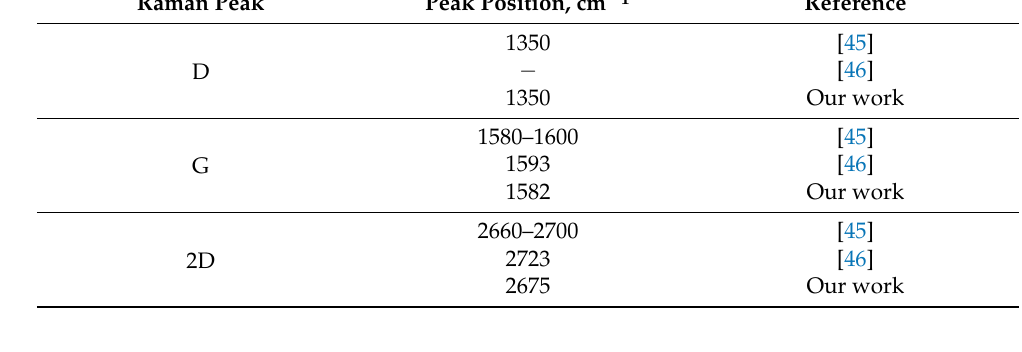
Figure 4. Raman spectrum of few − layer graphene on the copper substrate.